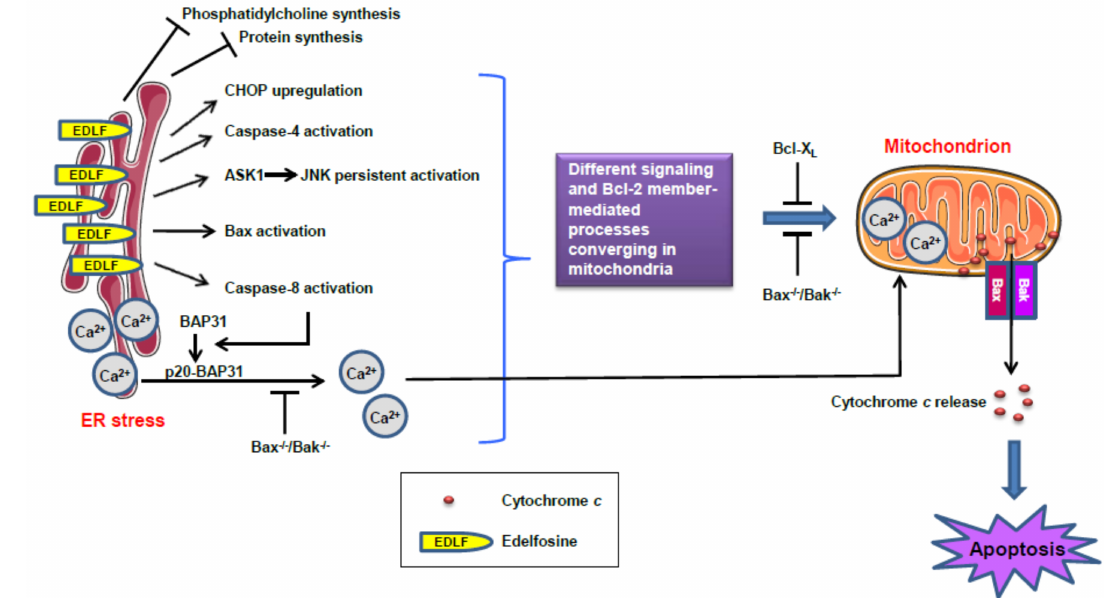
Figure 11. Schematic model of the ER’s involvement in the antitumor action of edelfosine in pancreatic cancer cells. Edelfosine is selectively taken up by tumor cells and accumulates in the ER. This targeting of the ER by edelfosine leads to a persistent ER stress response characterized by the different biochemical processes depicted in the schematic diagram. These events lead to apoptosis through a mitochondria-dependent process. See text for